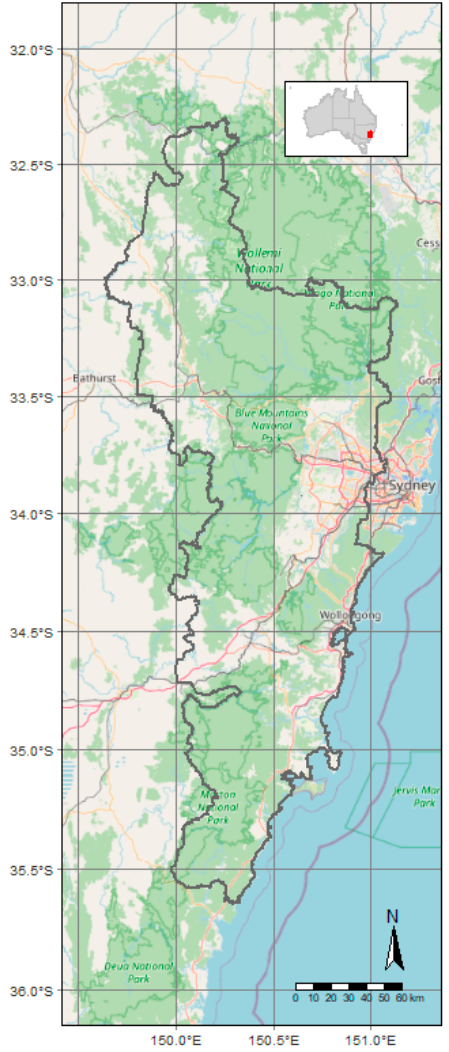
Figure 1. The Endeavour Energy network coverage area.